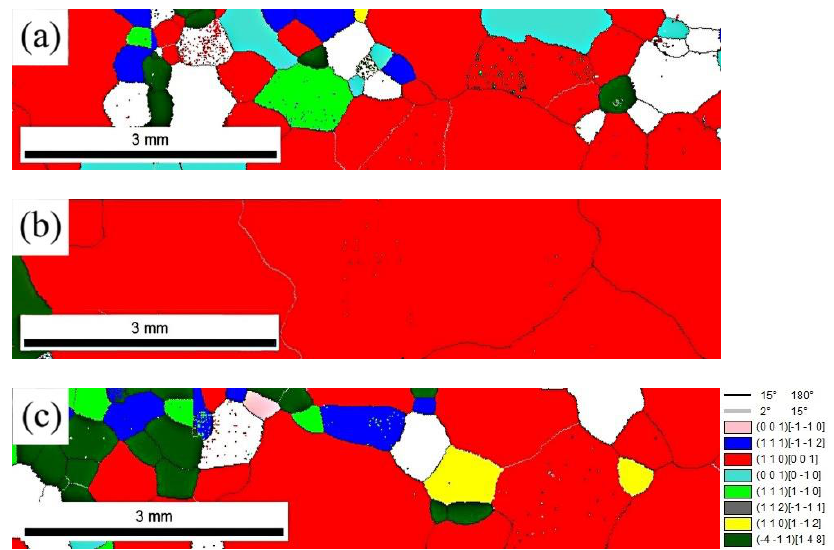
Figure 8. EBSD orientation maps after high-temperature annealing with different decarbonization annealing times of ( a ) 3 min, ( b ) 5 min and ( c ) 7 min. Table 3. Texture content after 850 C high-temperature annealing with different decarbonization annealing times.